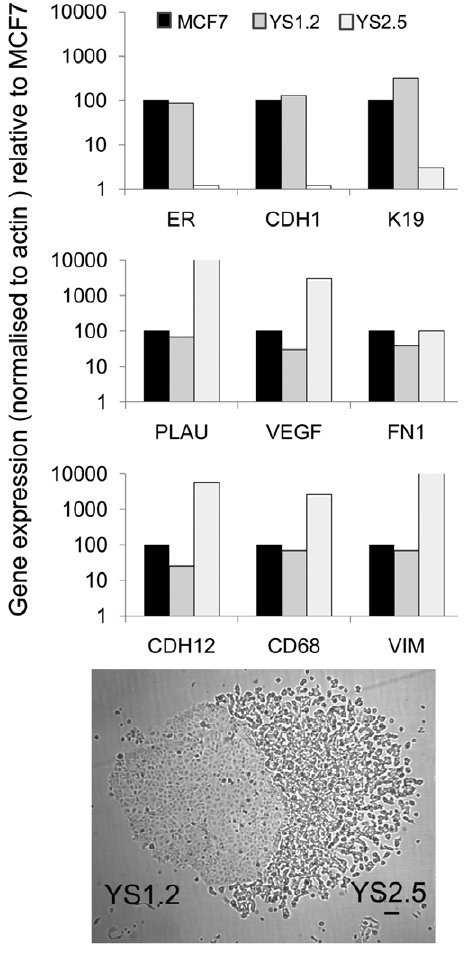
Figure 8. Realtime PCR analysis of epithelial and mesenchymal markers in MCF7, YS1.2 and YS2.5 cells. Extracted RNA was converted to cDNA and amplified using the Taqman procedure as described in Methods. Histograms represent means of duplicate determinations. Similar results were obtained in two separate experiments. Expression was normalized to the level found in MCF7 cells (arbitrarily fixed as 100), with b actin used as an internal control. Photomicrograph shows the morphology of the two original adjacent G418 resistant colonies from which YS1.2 and YS2.5 were cloned. Scale bar represents 100 m